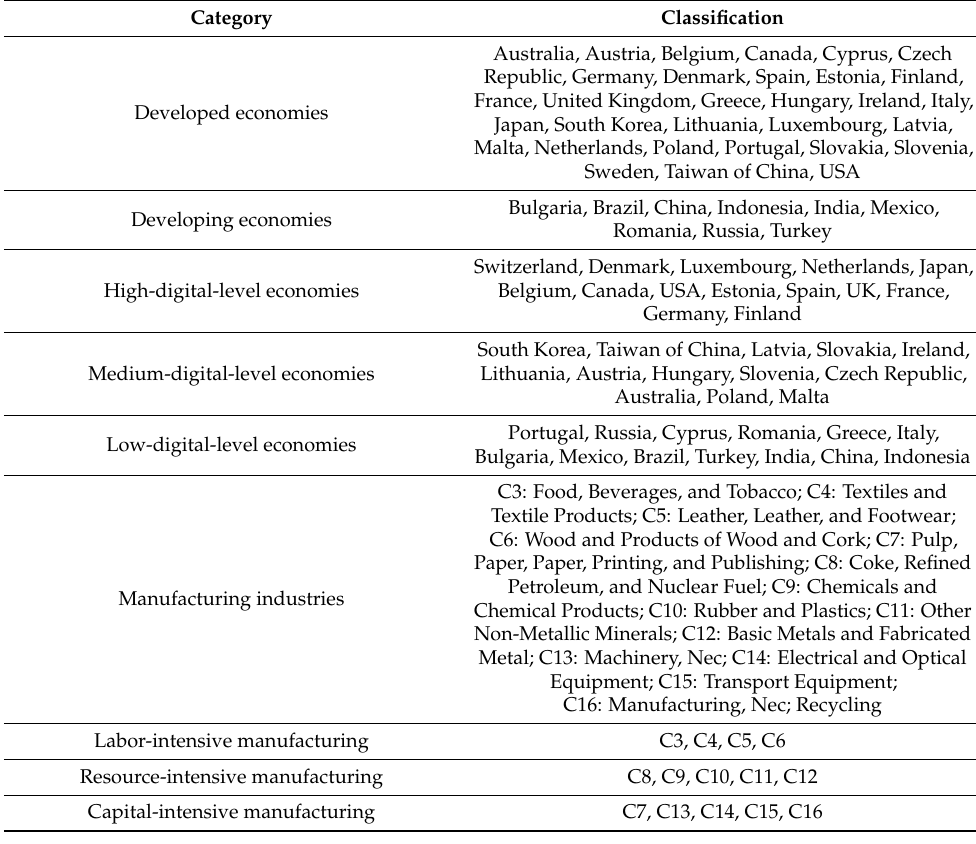
Table 2. Classification of economies and manufacturing